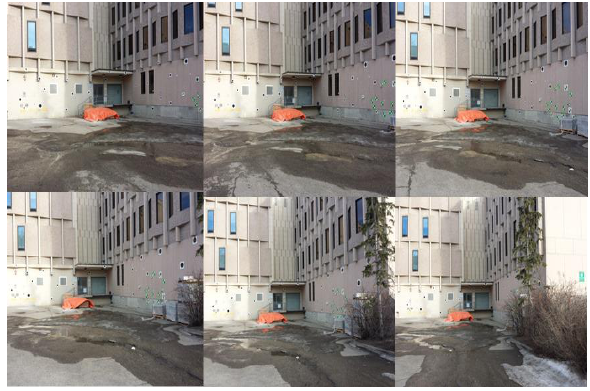
Figure 8. The taken six images.